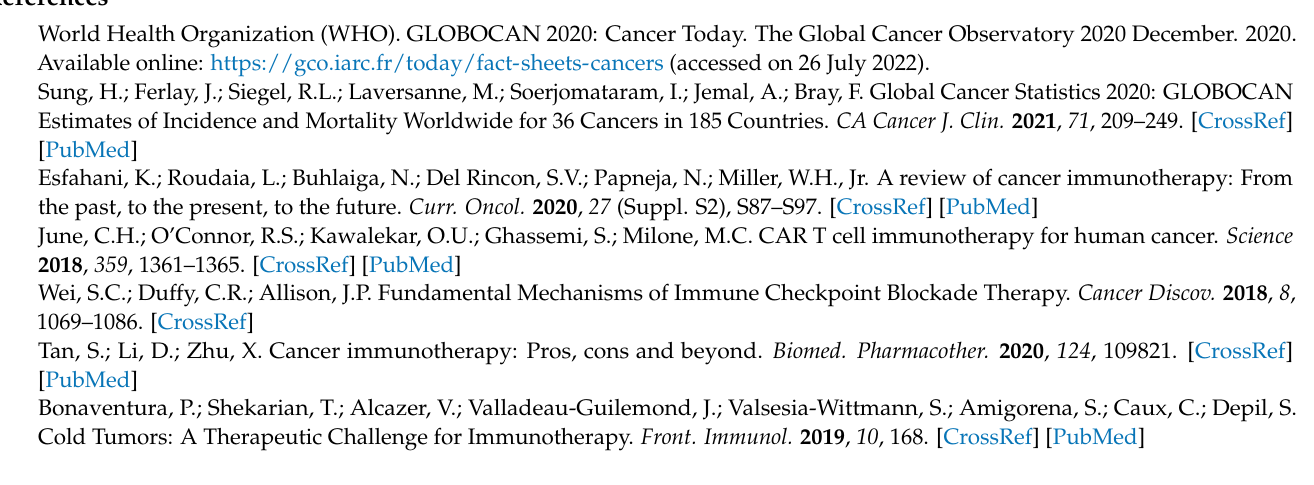
Figure S3: Dynamics of parasitemia in the mice of the combination therapy experiments; Figure S4: Effect of different X-ray dose on LLC tumor growth; Figure S5: Representative plots of gating strategies in flow cytometry analysis; Figure S6: The effect of PI in combination with RT on the immune profiles in tumor tissues in subcutaneous LLC lung cancer-bearing mice; Figure S7: The effect of PI in combination with RT on the spleen weight in subcutaneous LLC lung cancer-bearing mice; Figure S8: The effect of PI in combination with RT on the profiles in the spleens in subcutaneous LLC lung cancer-bearing mice; Figure S9: The effect of PI in combination with RT on the immune profiles in peripheral blood in subcutaneous LLC lung cancer-bearing